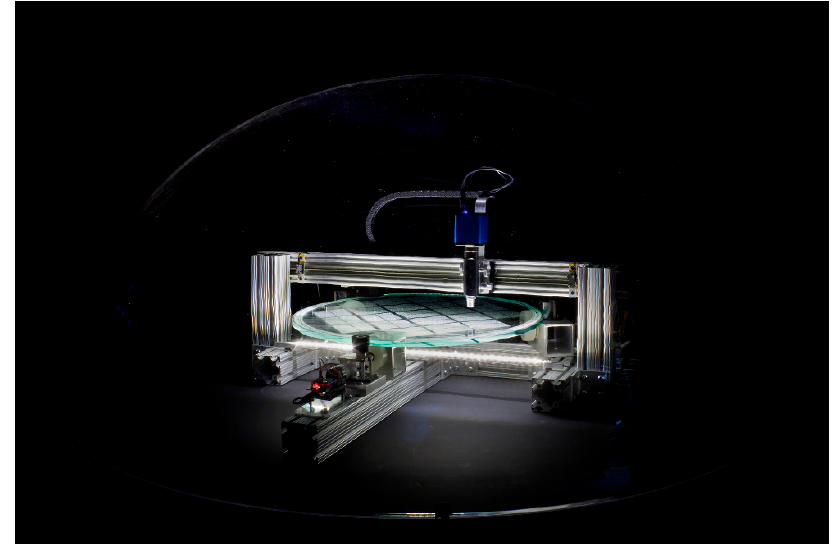
Figure 3. “Somnium” (2016) Robotic installation based on Kepler’s Space Telescope data, produced in a SETI Institute residency by Marko Peljhan, Danny Bazo, Karl Yerkes. Used by permission of Daniel Bazo. Photograph by Daniel Bazo.